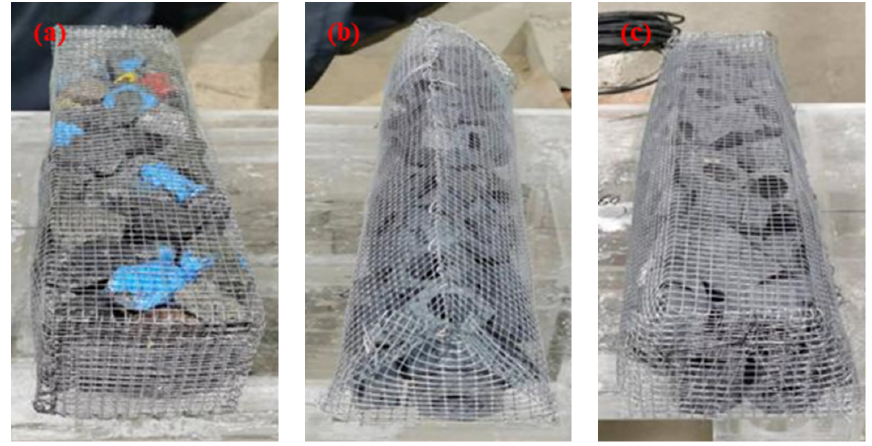
Figure 6. Simplified models of submerged breakwaters (( a ) rectangle; ( b ) triangle; ( c ) trapezoid).